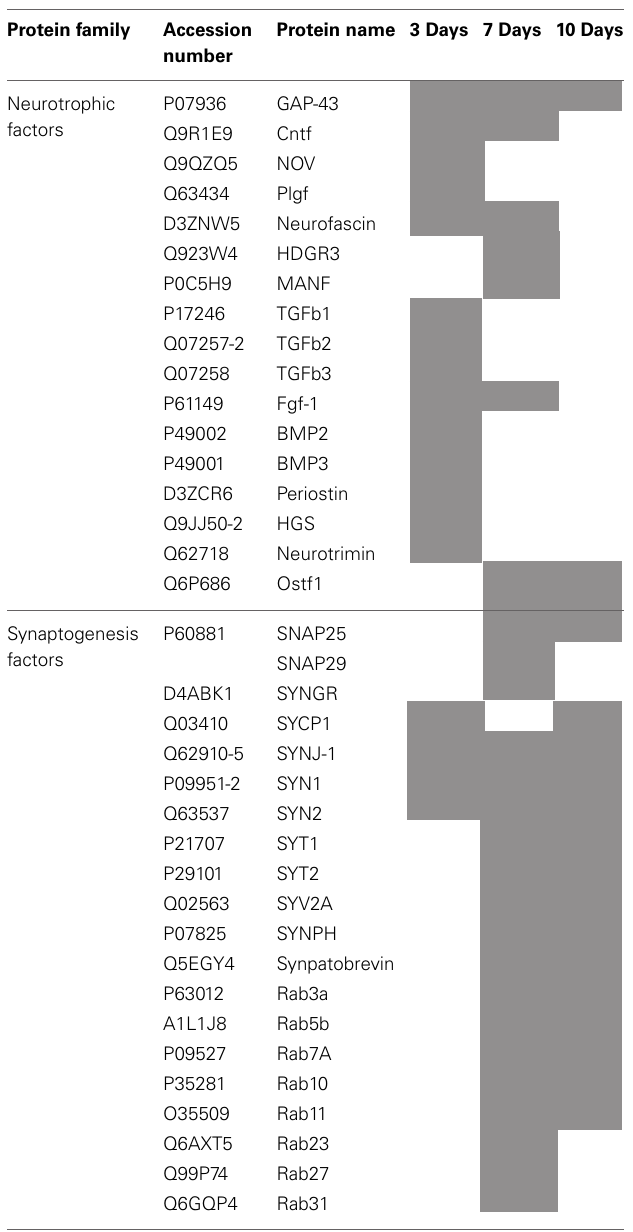
Table 2 | Identified proteins from rostral tissue sections in time course after